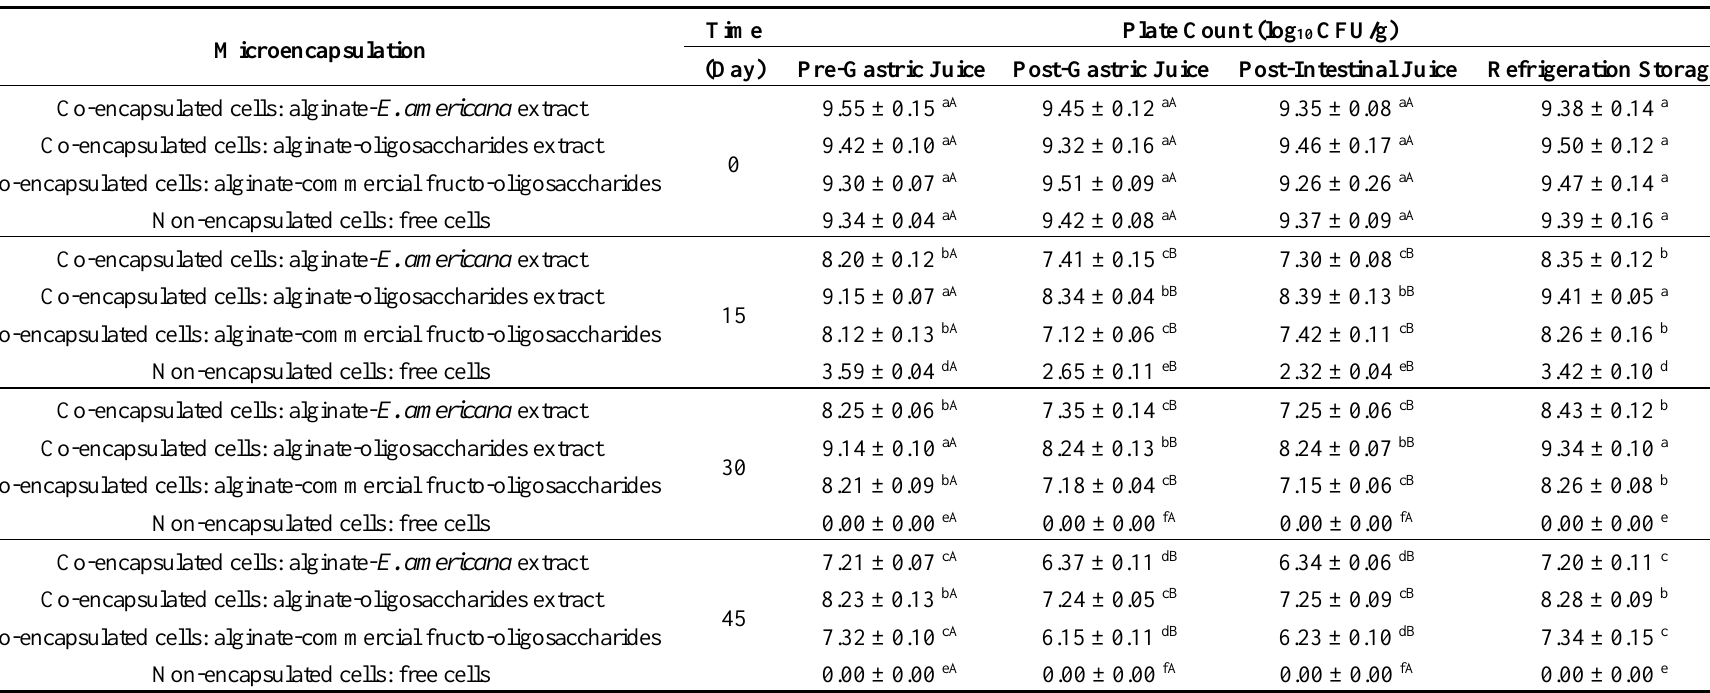
Table 3. Survival of microencapsulated Bifidobacterium longum with Eleutherine americana in pineapple juice during sequential incubation in simulated human gastric and intestinal juices and refrigeration